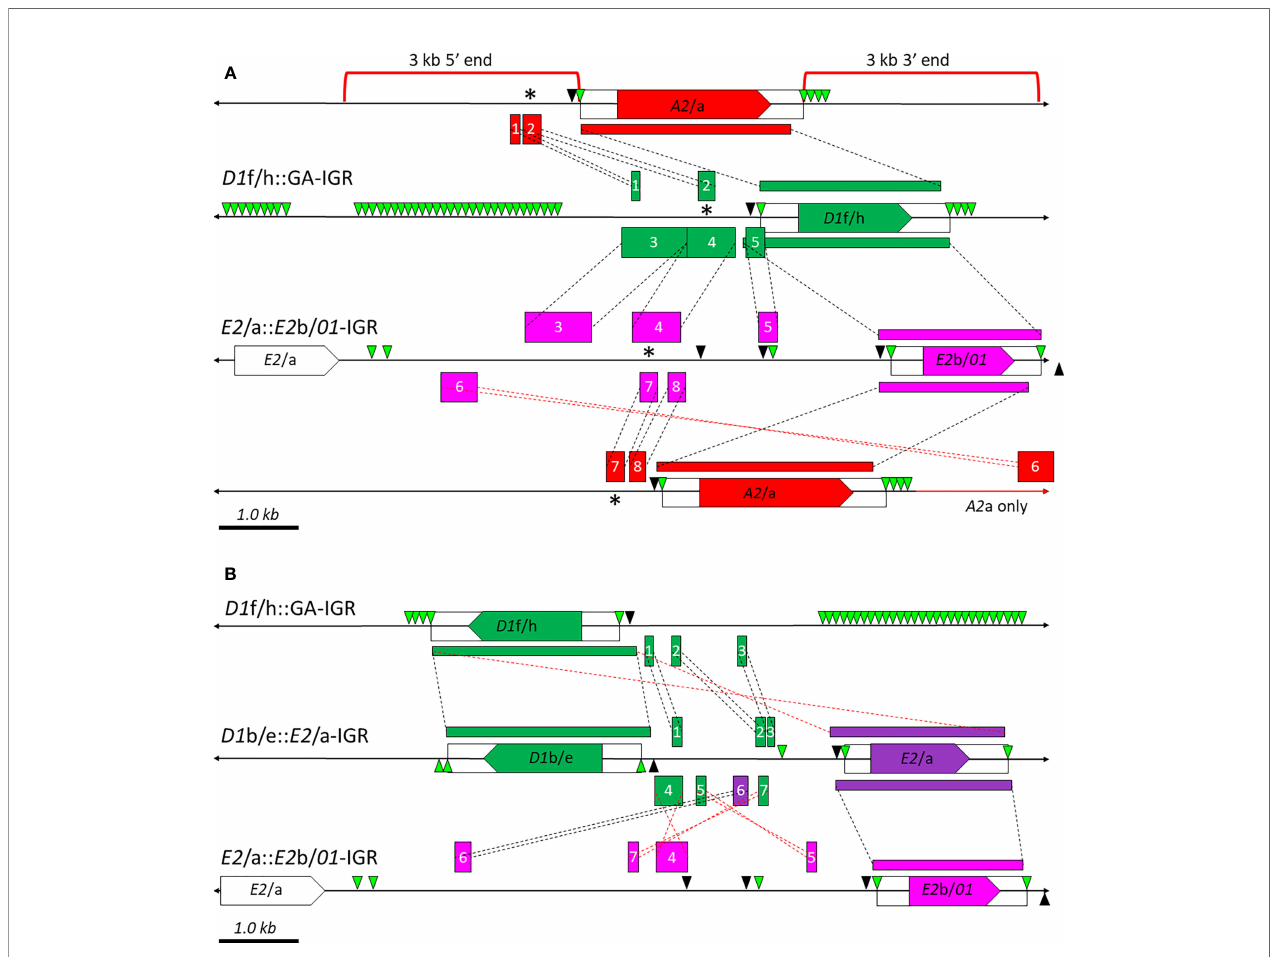
FIGURE 8 | Comparisons the IGRs between the A2 , E2 , 01 , and D1 f/h genes identify short regions of similarity. (A) The D1 f/h::GA-IGRs and E2 /a:: E2 b/ 01 -IGRs are compared to each other, and both are compared to the 5 ʹ and 3 ʹ ends of the A2 /a genes (indicated by red brackets). (B) The D1 f/h::GA-IGRs, D1 d/e:: E2 /a-IGRs, and the E2 /a:: E2 b/ 01 -IGRs are compared. Genes are indicated by the polygon labeled with the gene name and are colored according to Figure 1A and are fl anked by UTRs (open boxes). The genomic DNA is indicated by horizontal black lines that passes behind the genes and includes the IGRs and fl anking regions. Genes without color were not included in the analysis and are shown for orientation and comparison to Figure 1A . GA (green triangles) and GAT (black triangles) STRs are indicated. The colored boxes above and below the black horizontal line indicate regions of similarity as identi fi ed from dot plots from the YASS genomic similarity search tool set to a threshold of e -20 . Areas of shared sequence among IGRs are numbered for clarity; see text for detailed description. Dotted lines connect the regions of similarity between IGRs including regions in the same (black lines) and inverted (red lines) orientation. This fi gure is drawn to scale. * indicates regions of similarity among all three alignments in (A)